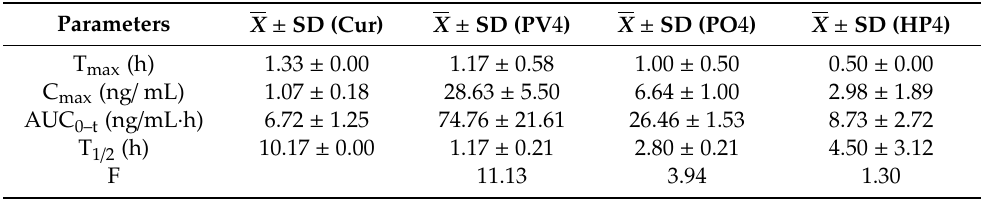
Figure 13. Plasma Curcumin Curve after a single oral dose of PV4 and Curcumin ( n = 3) in male SD rats: Male Sprague-Dawley rats (7 weeks old and weighing 240–280 g) were used. Rats were fasted for 12 h prior to the beginning of experiments. All groups received Curcumin: Curcumin, PV04, HP04, and PV04 suspension in water with 5% ( v / v ) PEG 400, n = 3. One mL of eye blood was collected at 0.5, 1, 2, 4, 6, and 8 h post-dose. Table 2. Pharmacokinetic parameters after oral administration of Curcumin and Curcumin solid dispersion calculated by a non-compartmental